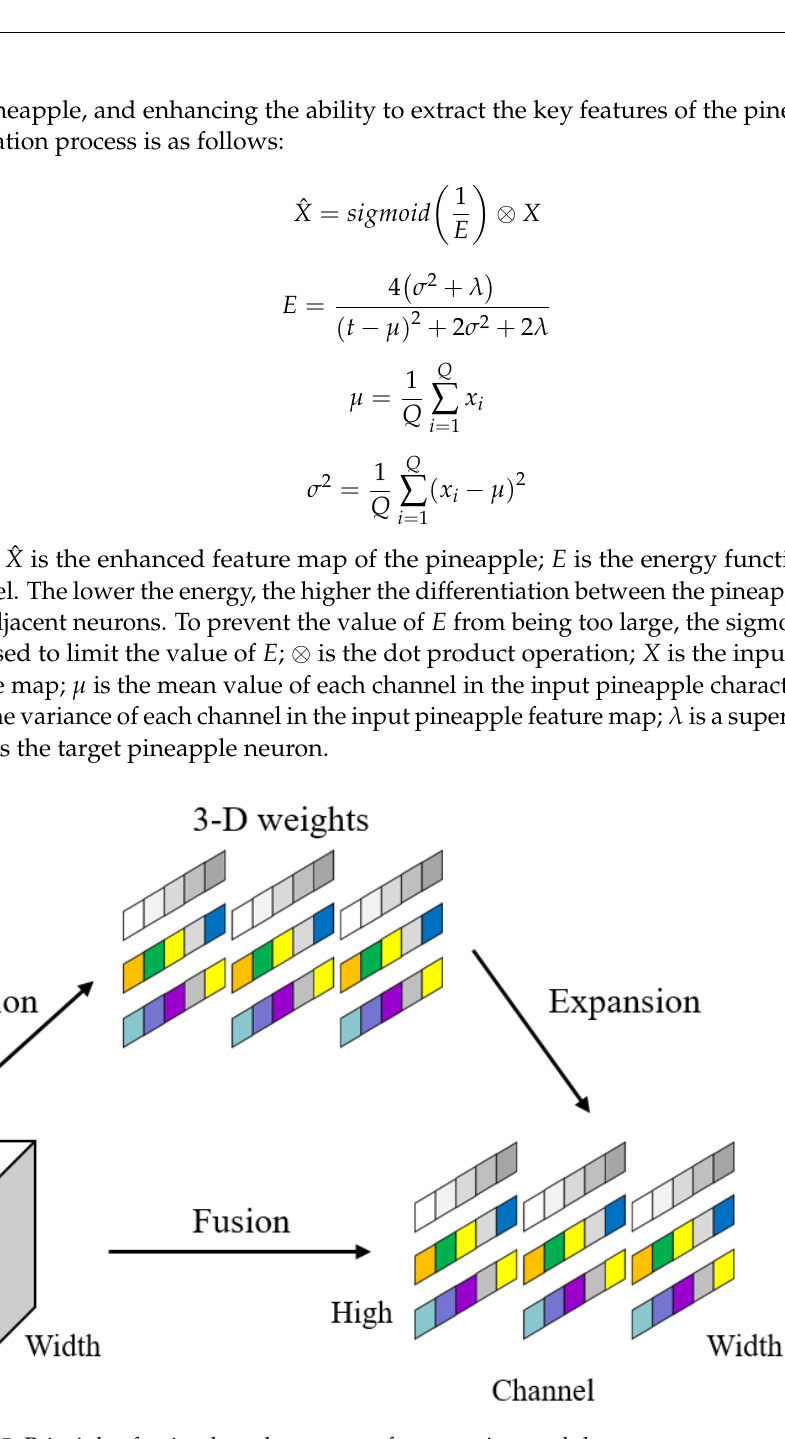
Figure 6. Convolution process with a stride of two.